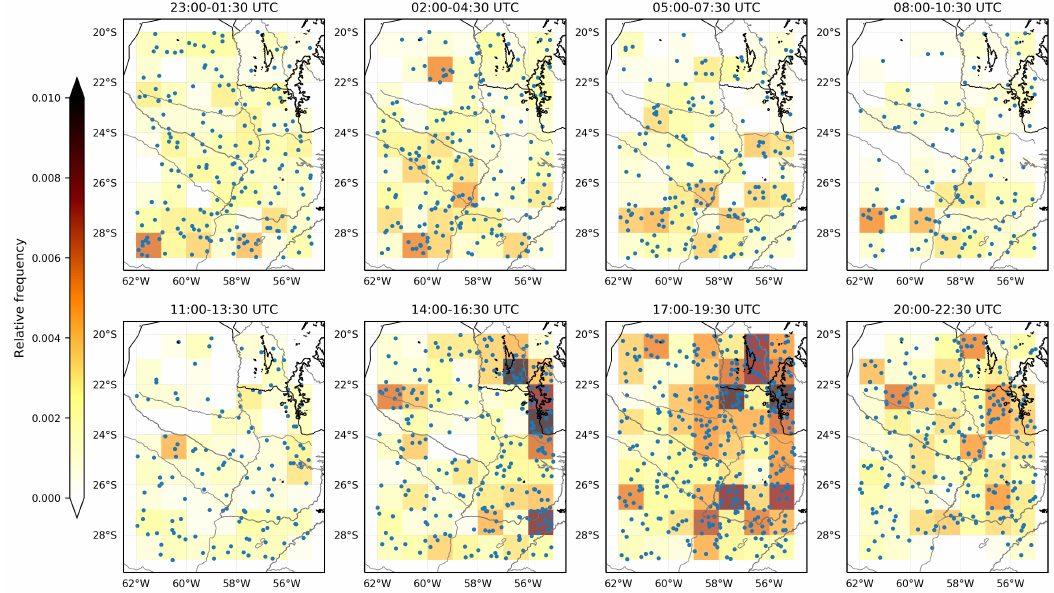
Figure 13. Same as Figure 11, but for the northeastern Argentina and Paraguay (PN) region. CI sample size: